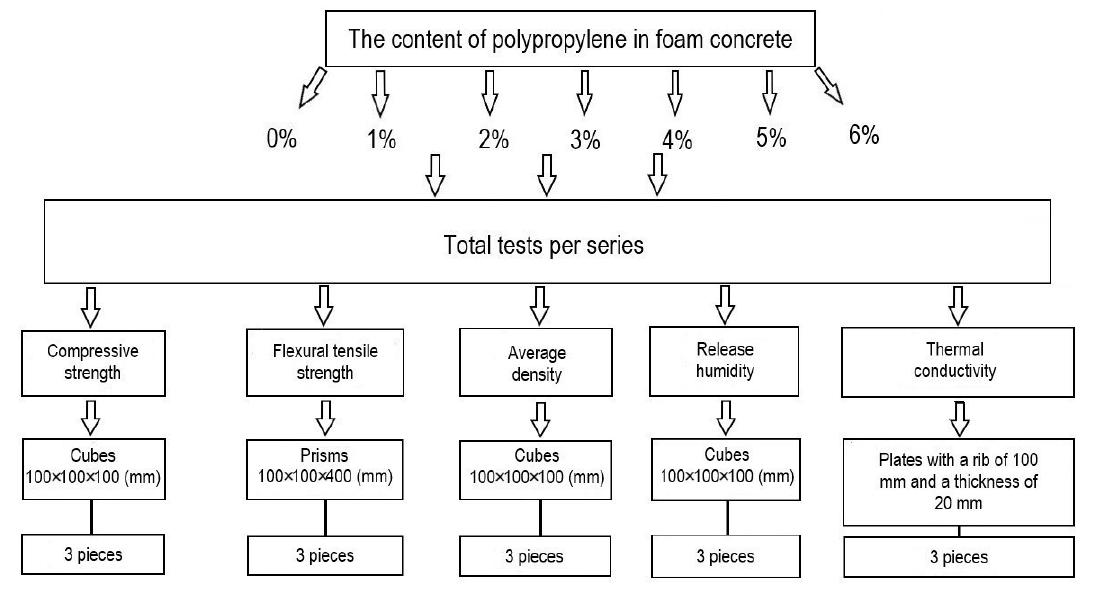
Figure 2. Design of the preliminary study. Table 5. Experimental research